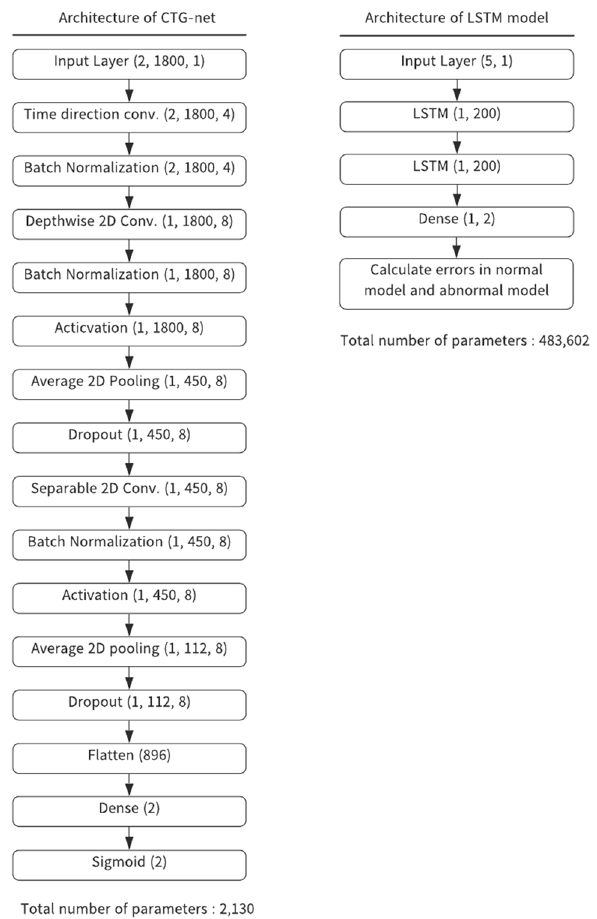
Figure 3. Architecture of DNN models. Left: The CTG-net is a CNN-based model with 3 convolutional layers. The model outputs abnormality and normality with values of 0–1. Right: The LSTM consists of 2 layers with 40 recurrent units. Input to the model is 5 consecutive data points of FHR and UC signals. The model predicts the next value of FHR and UC.